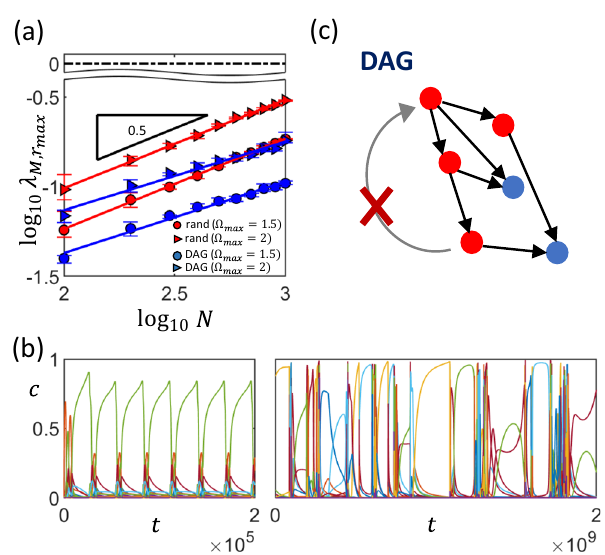
Fig. 2 Stability of random interaction networks. a For random interaction networks (red markers,`rand'), the maximal real part of the eigenvalues of ffiffiffiffi p the interaction matrix λ M ; r scales with N . Surprisingly, for random max directed acyclic networks (blue markers,`DAG'), λ M ; r also scales ffiffiffiffi p max approximately with N . In both of these cases, increasing the interaction strength from Ω max ¼ 1 : 5 (circles) to Ω max ¼ 2 (triangles) increases λ M ; r . max These results suggest that the system will become unstable (i.e., Þ exceeds 0, indicated by the black dashed line) when N or log 10 ð λ M ; r max Ω max becomes too large. Each data point is obtained from an average of 10 randomly drawn networks, with error bars indicating the interquartile range. Each random network is constructed by randomly selecting ρ N 2 interactions from N ( N − 1) possibilities, with half of the interactions chosen to be upregulating and the remaining half to be downregulating. The construction of DAGs is described in ( c ). For each regulatory interaction, fold change is chosen uniformly between 1 and Ω max . [Other parameters: ρ = 0.01, h = 1]. b When systems go out of stability, dynamics of protein concentrations c exhibit oscillatory (left, Ω max ¼ 20) followed by chaotic behavior (right, Ω max ¼ 200) as interaction strengths are increased. [Other parameters: N = 200, ρ = 0.2, h = 1, fully random network, time t is in units of 1/ k p .] c Random directed acyclic networks are constructed by randomly drawing connections between proteins (red circles represent TFs, blue circles represent non-TFs). If a drawn connection creates a loop (e.g., the gray arrow with a cross on it), it is